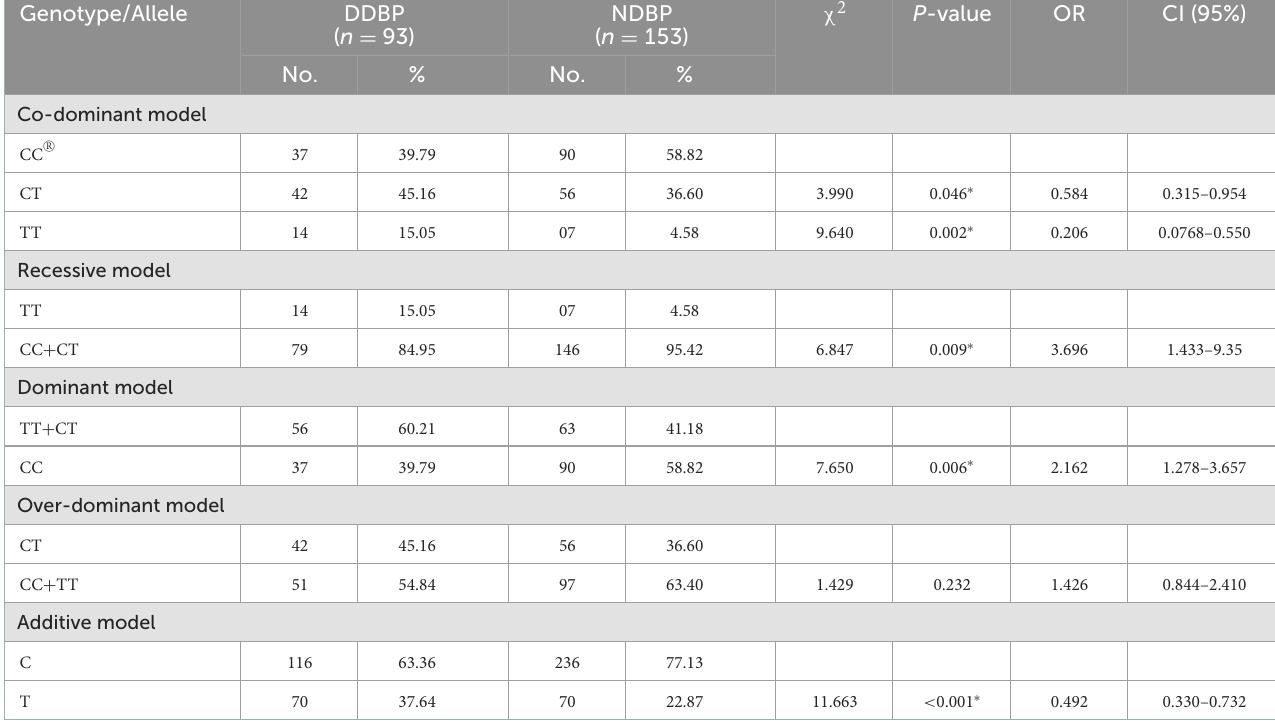
TABLE 7 BDNF gene polymorphism under co-dominant, recessive, dominant, over-dominant, and additive models in individuals with decreased DBP (DDBP) and normal DBP (NDBP).